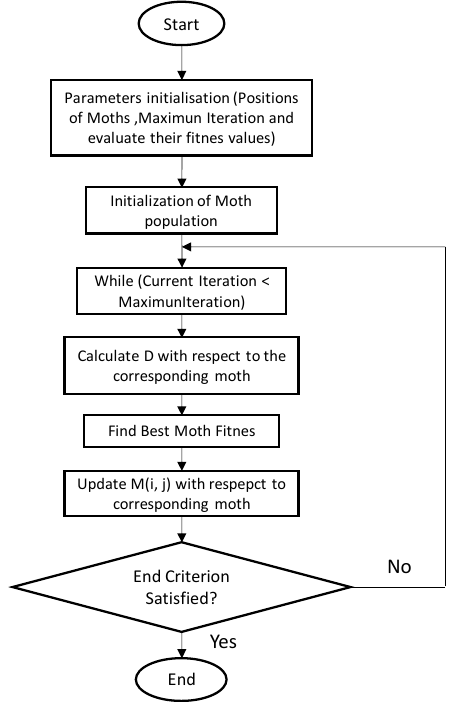
Figure 3. Flowchart of MFOA.